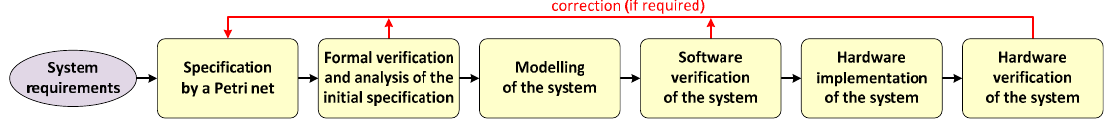
Figure 4. The framework of the proposed design method.